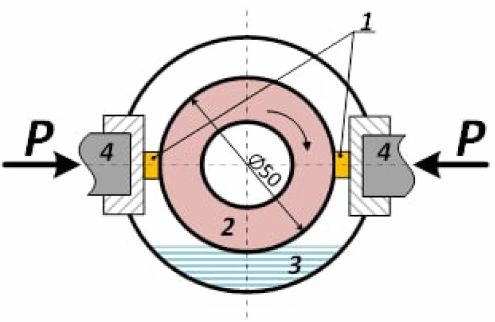
Figure 1. Tribological test scheme. 1—blocks, 2—disk, 3—water, 4—pressure hydraulic cylinders. The sliding speed values were 0.8 m/s, 1.2 m/s, 2.4 m/s, and 3.6 m/s with a normal load of 100 N.